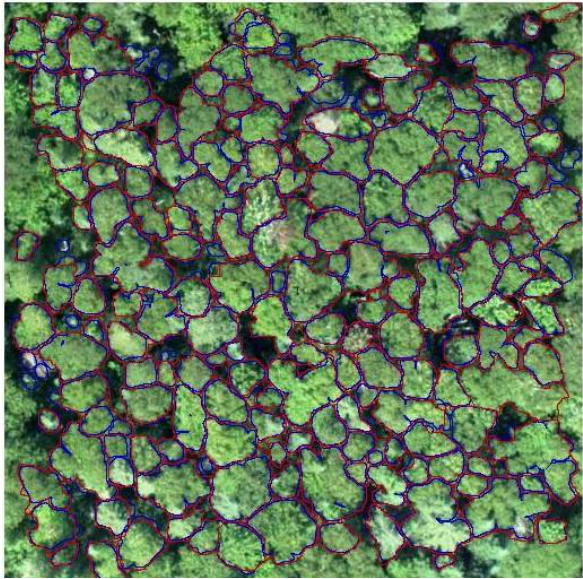
Figure 6. ITC delineation result (blue circle) generated by U-net, together with the tree crowns manually labelled (red circles) for the test size #2.